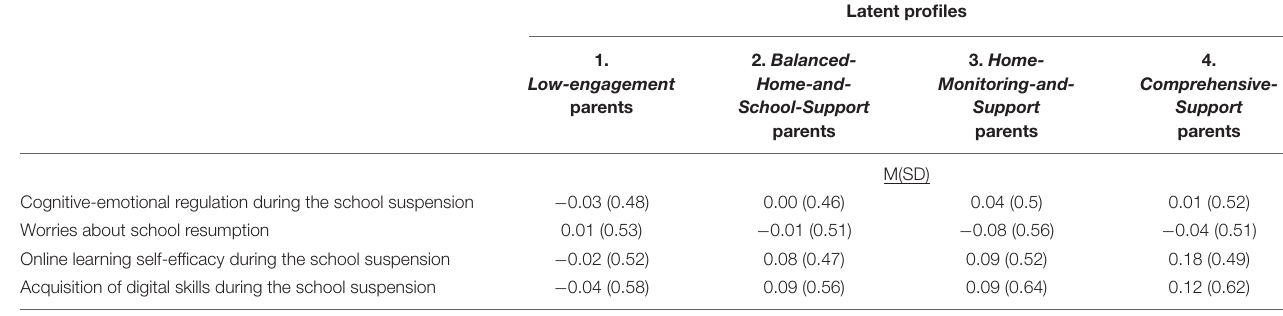
TABLE 13 | Descriptives for of student outcomes (secondary schools).